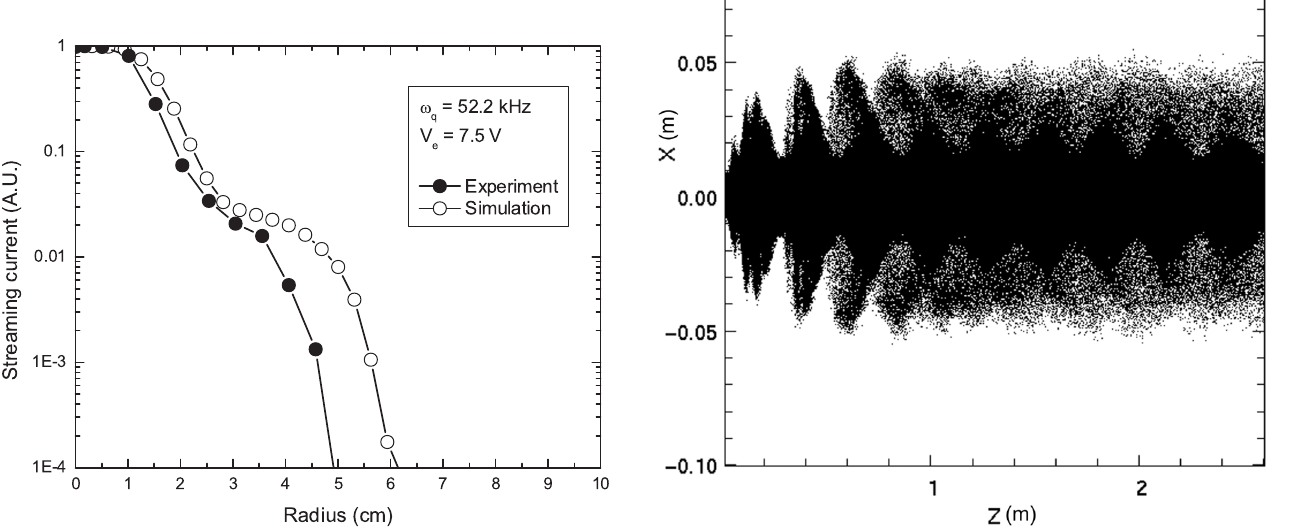
FIG. 2. The radial profile of the axial current streaming from the ion source to the charge collector in a single pass. Both experiment (solid circles) and simulation (open circles) show a shoulder around r (cid:2) 3 cm .